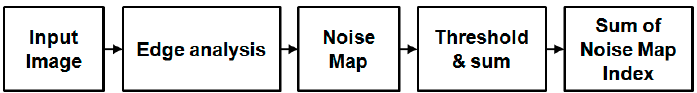
Figure 6. Measurement principle for a sum of noise map (SNM) index. Sensors 2018 , 18 , 60